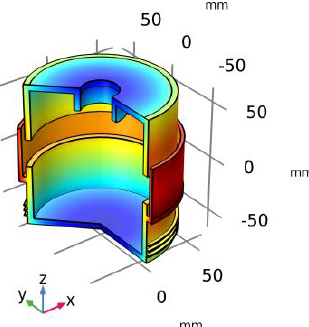
Fig. 1. The tested can screen